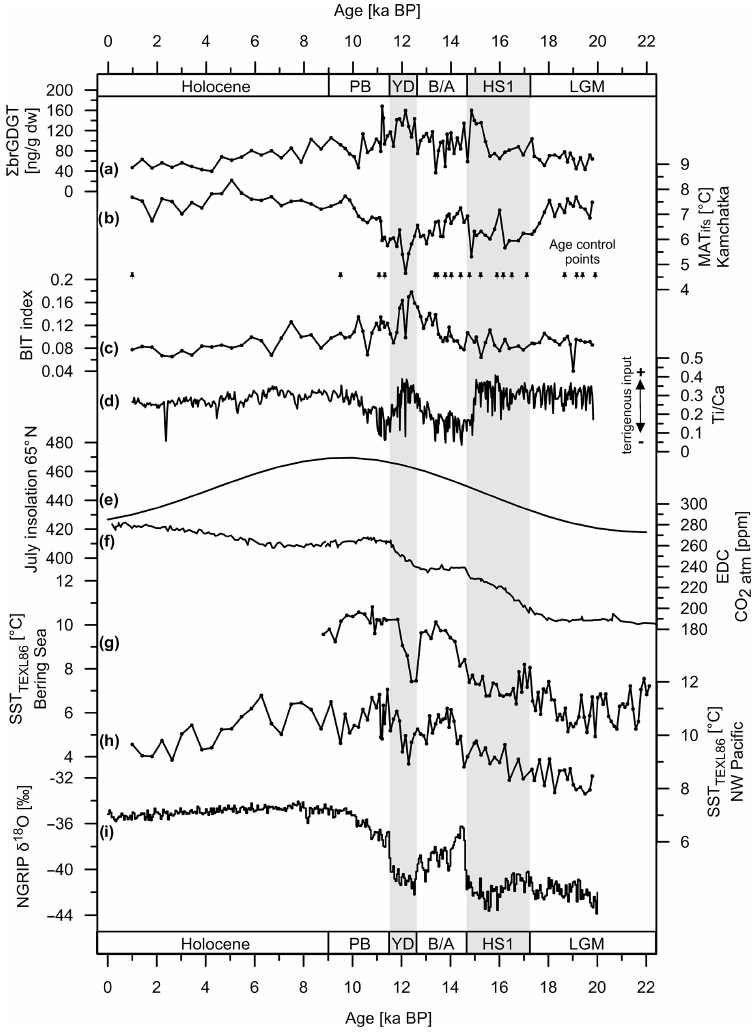
Figure 2. (a) Concentrations of (cid:54) brGDGT of core 12KL. (b) MAT ifs derived from CBT–MBT (cid:48) from Kamchatka (this study). Black pins represent the age control points from core 12KL (based on radiocarbon dating of planktonic foraminifera; Max et al., 2012). (c) BIT index values of core 12KL (Meyer et al., 2016). (d) Titanium / calcium ratios (Ti / Ca, XRF-scan core 12KL; Max et al., 2012). (e) Mean July insolation at 65 ◦ N (Berger and Loutre, 1991). (f) Atmospheric CO 2 concentration (EPICA dome C; Monnin et al., 2001; Parrenin et al., 2013). (g) SST development in the marginal NW Pacific (site 12KL; Meyer et al., 2016). (h) SST evolution in the western Bering Sea (site 114KL; Meyer et al., 2016). (i) NGRIP δ 18 O (NGRIP members, 2004) represents climate change in the N Atlantic. Grey shaded bars mark the HS1 and YD